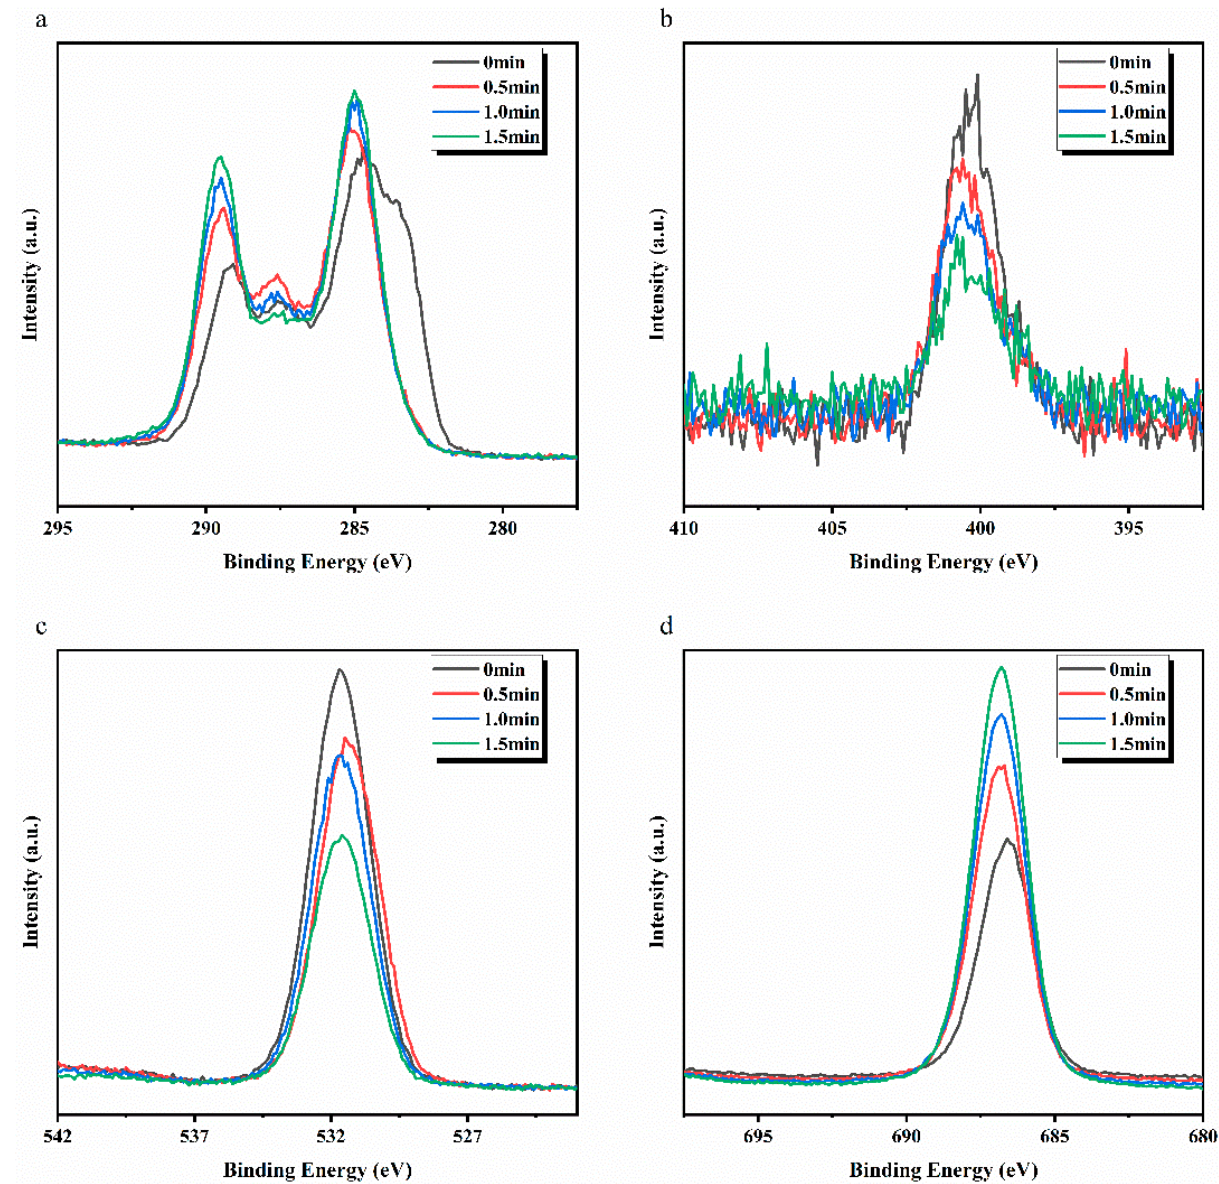
Figure 6. Comparison of peak intensity for each element on the surface of ETFE-2 membrane in a function of sputtering time: ( a ) C, ( b ) N, ( c ) O, and ( d ) F.